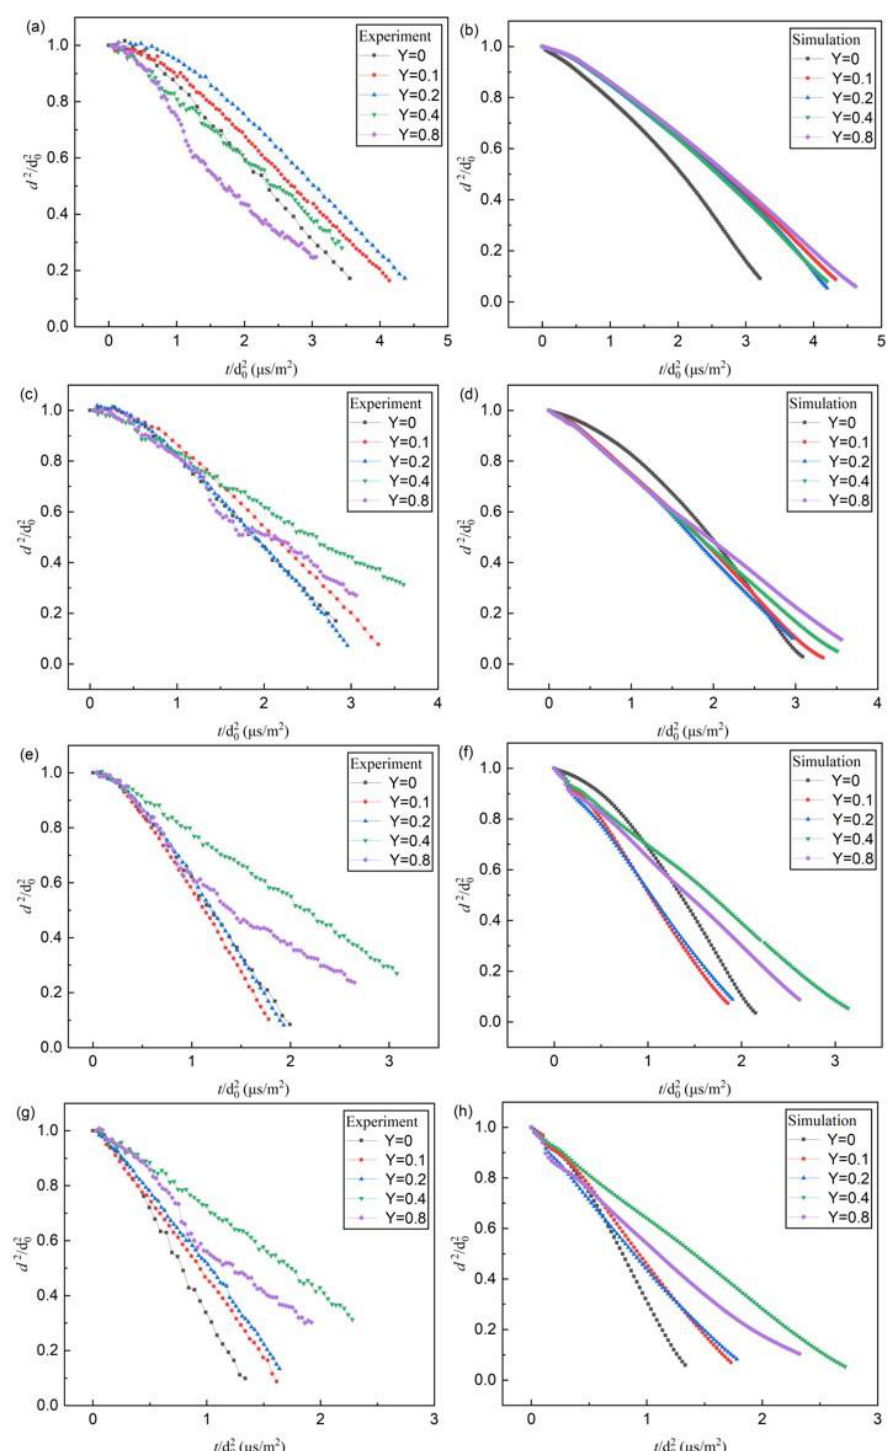
Figure 5. The experimental and numerical evaporation curves of bi-component droplets with different mass fractions of ethanol at different ambient temperatures: ( a ) experimental curves at 573 K; ( b ) numerical curves at 573 K; ( c ) experimental curves at 673 K; ( d ) numerical curves at 673 K; ( e ) experimental curves at 773 K; ( f ) numerical curves at 773 K; ( g ) experimental curves at 873 K; ( h ) numerical curves at 873 K.